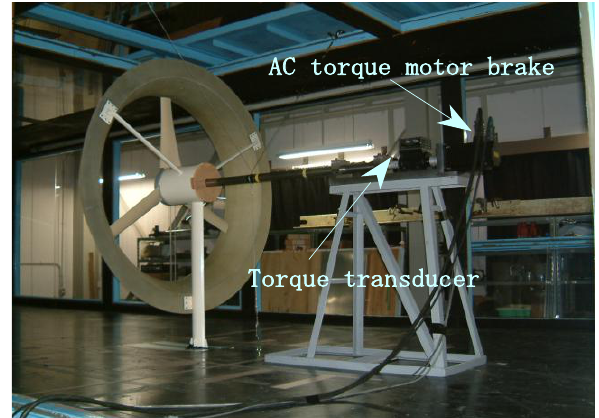
Figure 10. Output performance test of a wind-lens turbine in a wind tunnel.